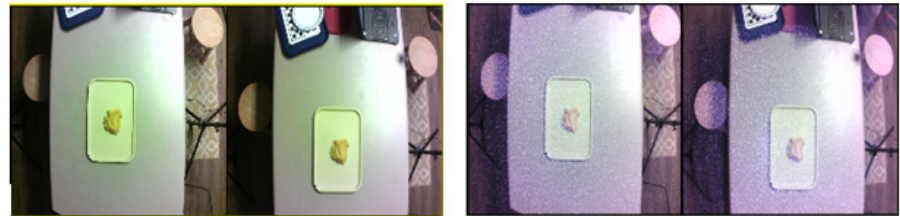
Figure 6. ( Left ) RGB stereo images captured by the FOODCAM (unrectified); ( Right ) RGB + IR stereo images captured by the FOODCAM (unrectified).